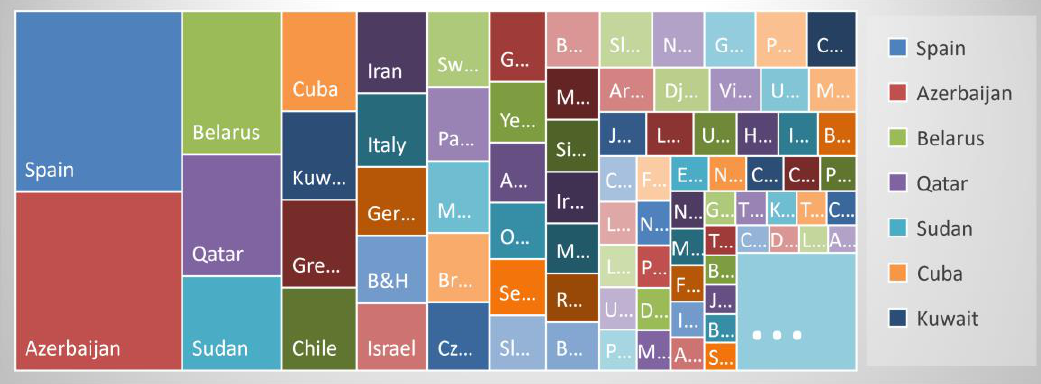
Figure 3. Visualization of countries based on the ISO 9001 certificates